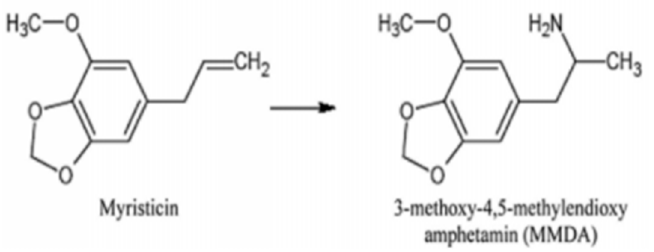
Figure 1. Molecular structure of myristicin and its active metabolite MMDA [9].